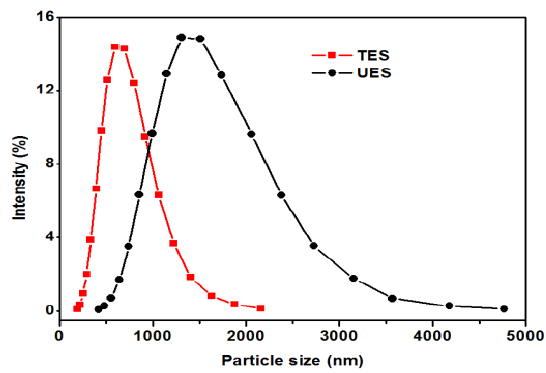
Table 4. Particle size and polydispersity index (PDI) of aqueous dispersion of UES and TES. Figure 6. Particles size distribution of UES and TES. Sample Mean Particle Size (nm)